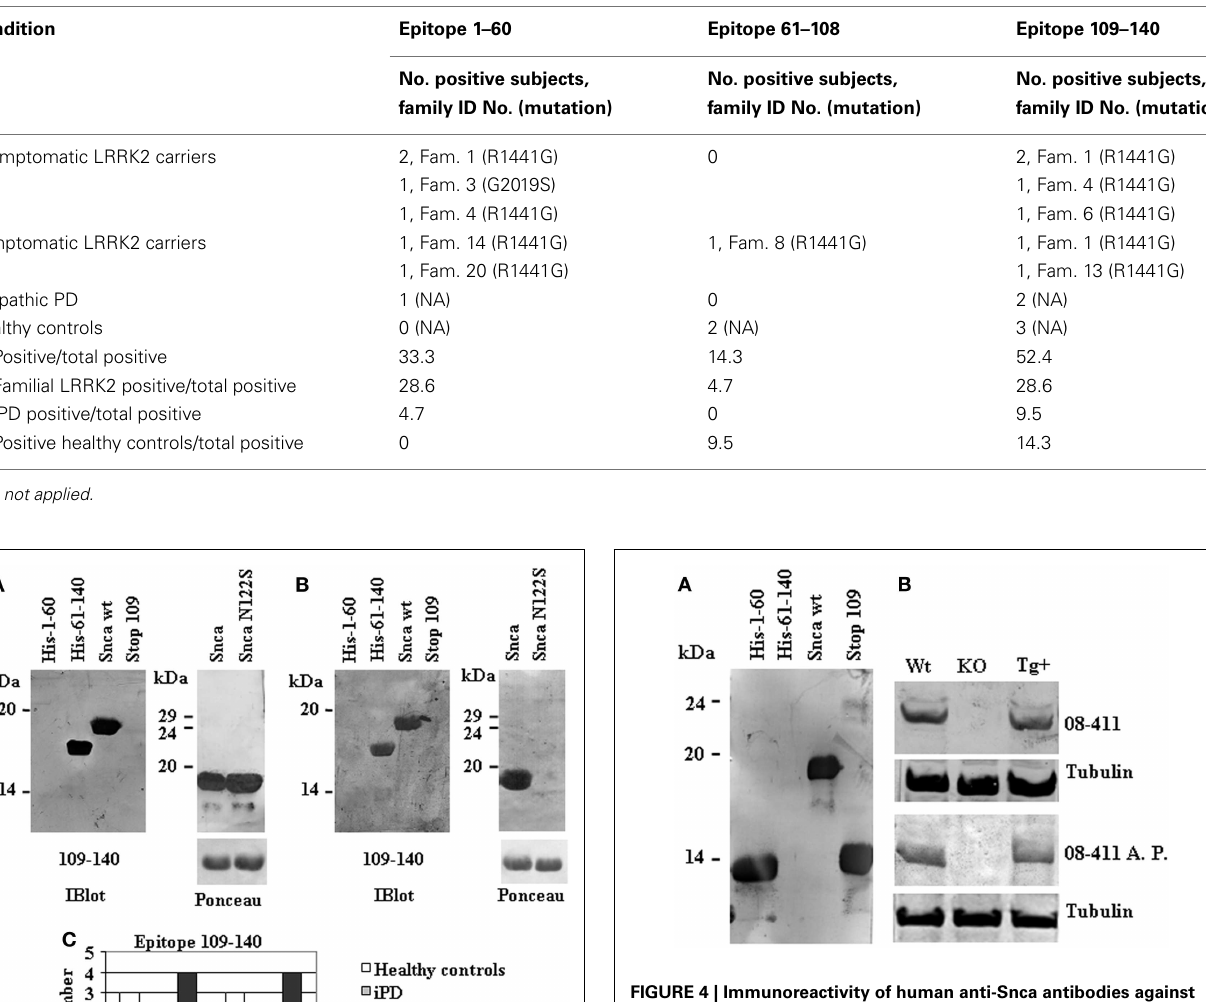
FIGURE 4 | Immunoreactivity of human anti-Snca antibodies against brain extracts from wild type (wt), Snca knock-out, and human Snca transgenic mice . Panels show the results obtained with the serum from patient 08–41, an asymptomatic LRRK2 patient. (A) Immunoblot analysis at 1/100 dilution against recombinant His-tag 1–60, His-tag 61–140, full length, and 1–108 (Stop 109) Snca showing that the main epitope was located at the N-terminal region of Snca (a.a. 1–60). (B) Immunoblot analysis of total serum upper part (08–411, 1/100 dilution) and affinity-purified anti-Snca antibodies [08–411 affinity-purified (A. P.) corresponding to 1/500 dilution of the original sample] against brain extracts prepared from wt, Snca knock-out, and humanTH-Snca transgenic mice (Tg +